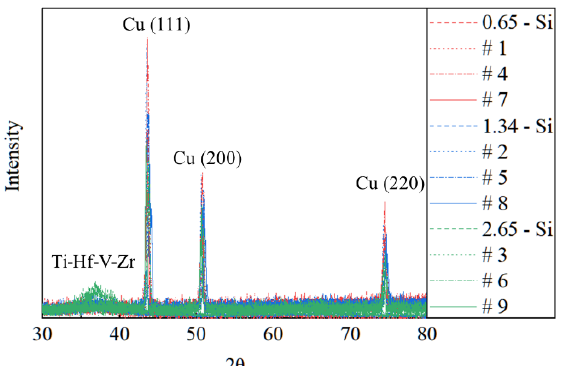
Figure 1. XRD of Ti-Hf-V-Zr films deposited on silicon and foamed porous copper substrates: 0.65 μ m, 1.34 μ m, and 2.65 μ m thick NEG-coated Si substrates; samples #1, #2, #3, #4, #5, #6, #7, #8, and #9.